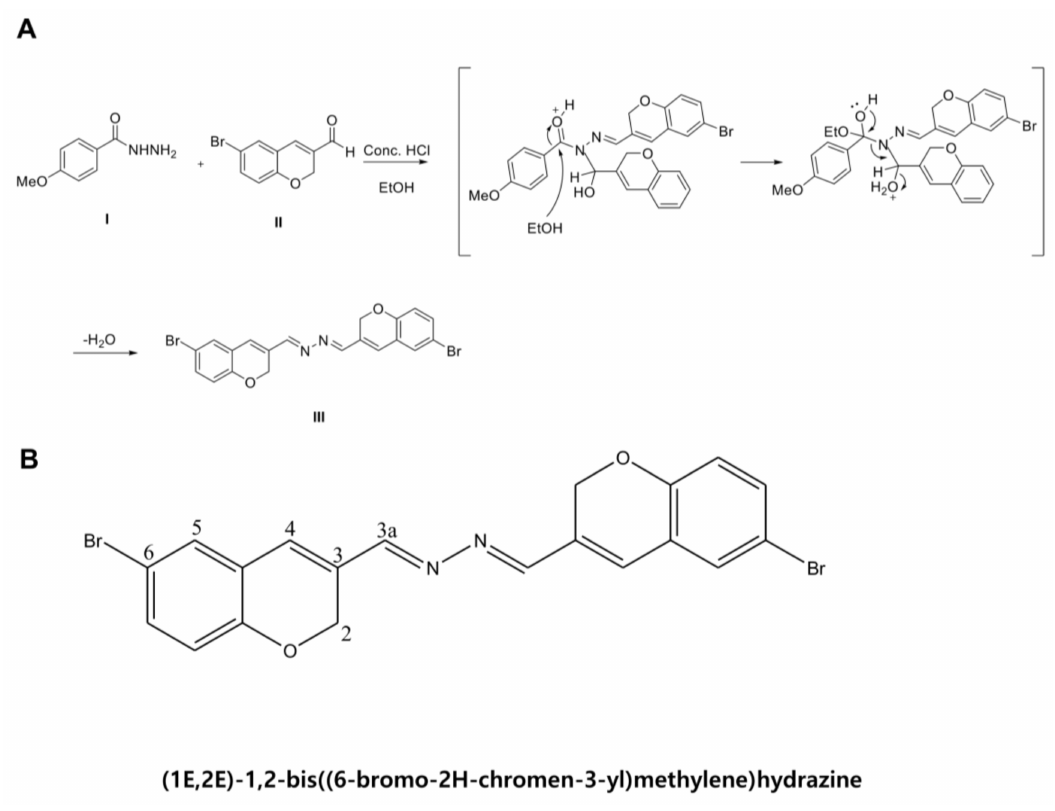
Figure 1. Scheme and chemical structure of BMM. ( A ) Scheme of BMM synthesis; ( B ) The structure and numbering of BMM,